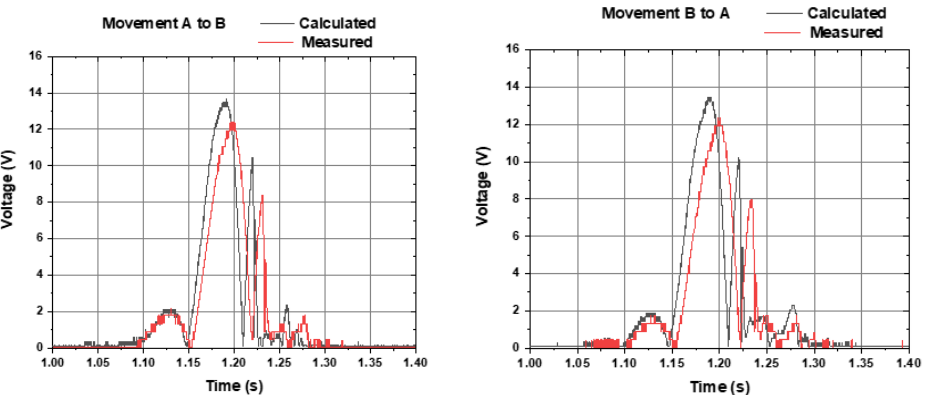
Figure 9. Calculated voltage (grey line) and experimentally measured voltage (red line) of the output, within a freefall movement from coil A to coil B ( left graph ) and from coil B to coil A ( right graph ). Coils were connected in parallel, followed by rectification.